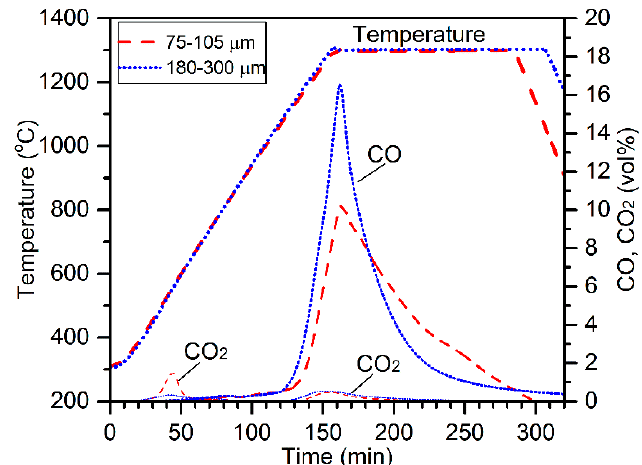
Figure 2. Temperature profiles and off-gas CO and CO 2 concentrations for the tests with the variation of chromite particle size.